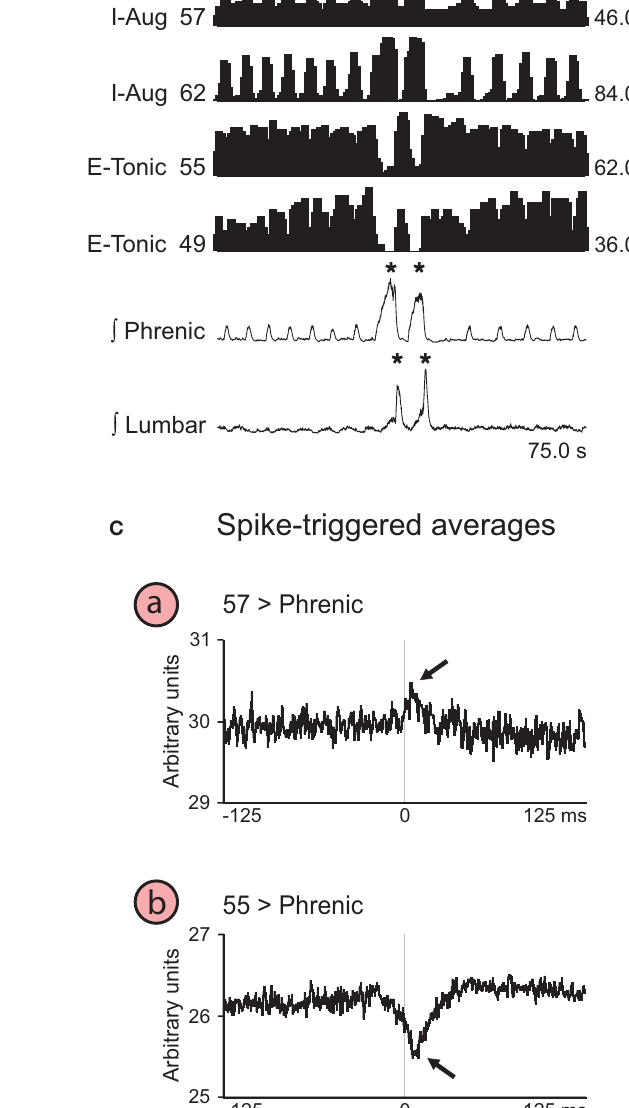
(B) Features in the CCHs are included in the correlation linkage map shown in (D) . Bin width for all CCHs = 0.5ms.The minimum and maximum bin values, normalized to spikes per second per trigger event, are shown for each correlogram. Feature description, detectability index (equal to the ratio of the maximum amplitude of feature departure from background activity divided by the SD of the correlogram noise), half-width, and numbers of trigger